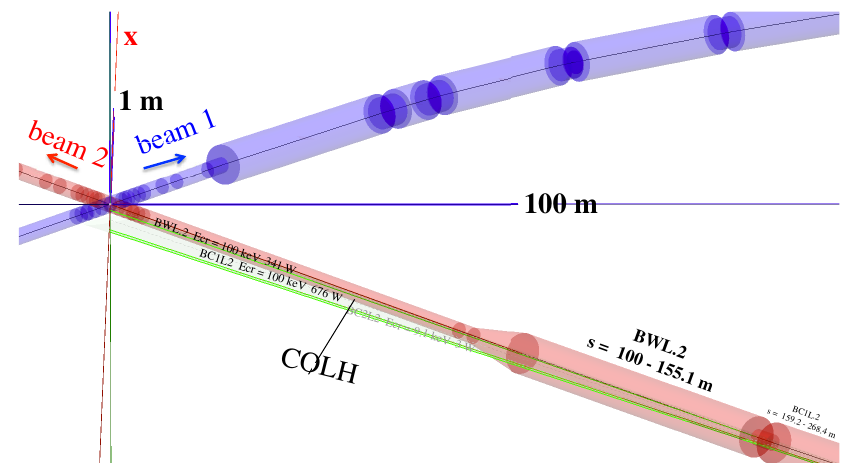
FIG. 4. SR from last bend upstream the IR from − 155 to − 100 m. Apertures are shown as circular with radius of 20 mm in the quads and 50 mm in the bends. The number of photons per crossing radiated by this bend towards the IP is 3 . 8 × 10 11 and the total energy is 1 . 2 × 10 7